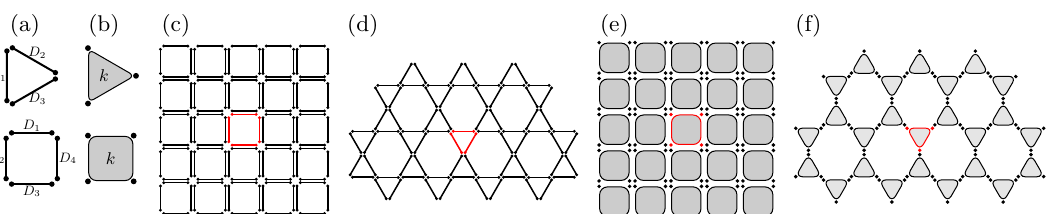
Figure 2: Examples of entanglement structures: (a) Plaquette tensors given by max- imally entangled states shared cyclically between three and four sites, where the indices D denote the number of levels of the entangled states; (b) same as in (a) but i with a GHZ-state of k levels shared between the sites; (c-d) entanglement structures on the square and kagome lattice, the plaquette shown in red indicates how to obtain those from the plaquette states from (a), neighbouring entangled states on the same edge can be reinterpreted as a single maximally entangled state with the number of levels squared; (e-f) same lattices as in (c-d) but with a generalized PEPS based on 3- and 4-party